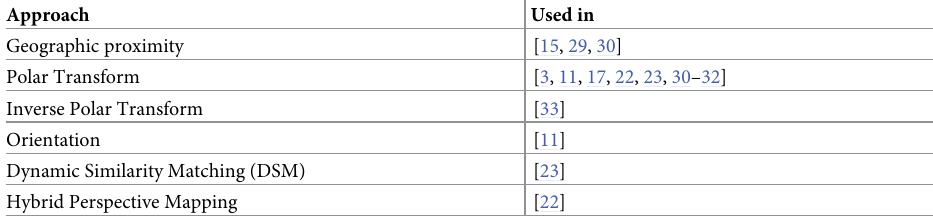
Table 2. An overview of the spatial (pose-wise) awareness approaches used in cross-view